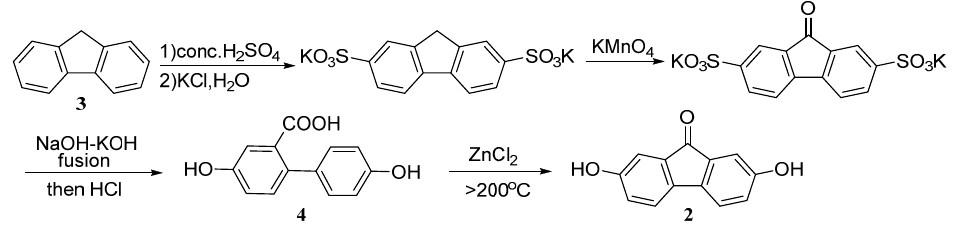
Scheme 1. Traditional synthetic route of 2,7-dihydroxyfluoren-9-one ( 2 ).